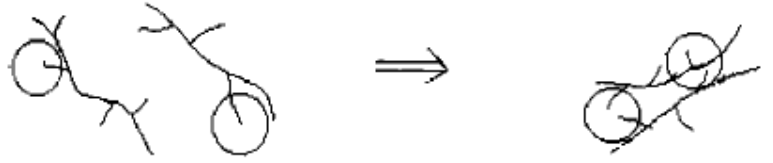
Figure 1. Physical model of the coagulation